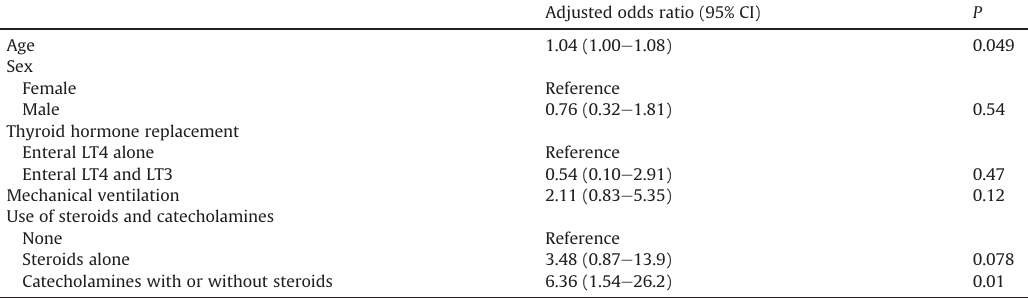
Table 4 Logistic regression for in-hospital